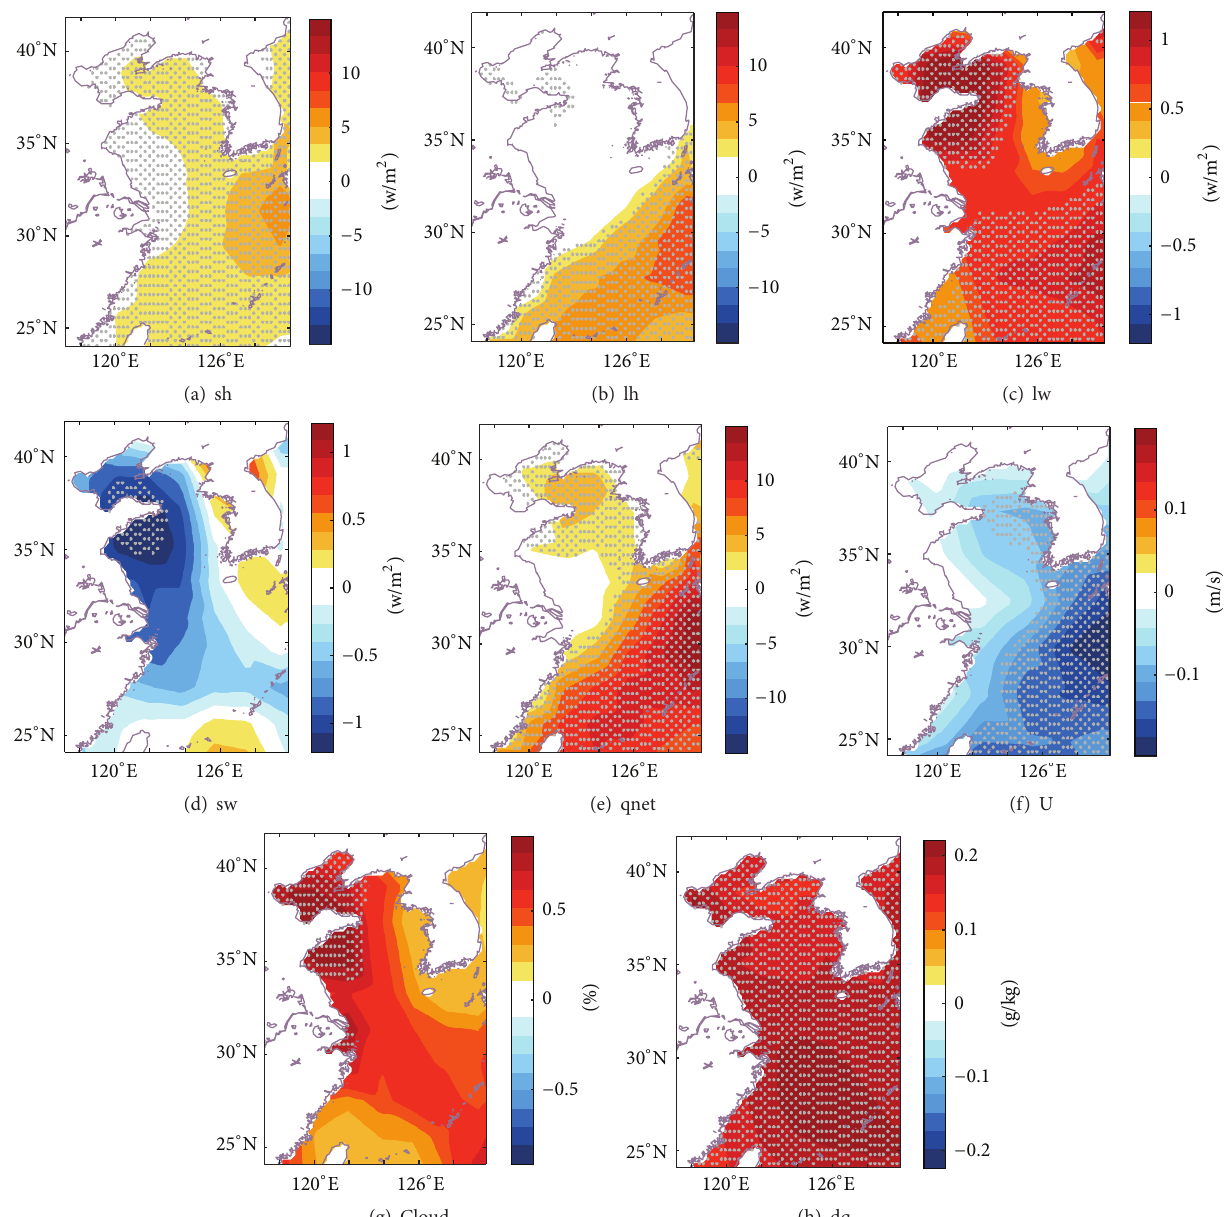
Figure 6: Regression maps of surface heat flux terms (positive downward), including (a) sensible heat flux, (b) latent heat flux, (c) long-wave radiation, (d) short-wave radiation, (e) net heat flux, (f) wind speed, (g) total cloud cover, and (h) specific humidity difference at 10 m against a lead of 1 month of the standardized NINO3 SSTA index. The gray spots denote 95% confidence level using Student’s 𝑡